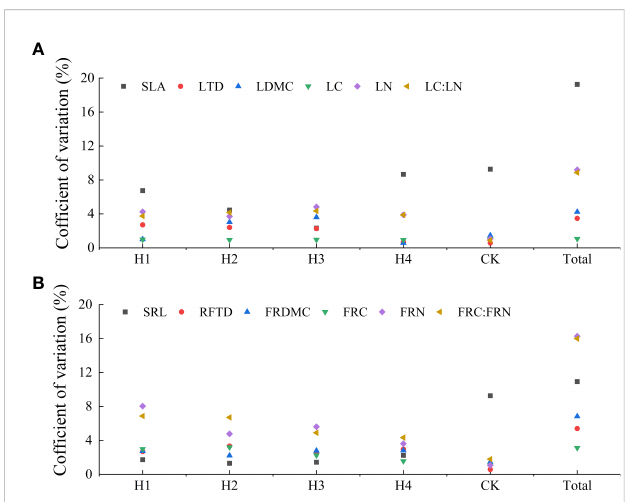
FIGURE 3 Variation traits of leaves (A) and fi ne roots (B) at different stump heights. Speci fi c leaf area (SLA), Leaf tissue density (LTD), Leaf dry matter content (LDMC), Leaf C content (LC), Leaf N content (LN), Leaf C:N ratio (LC : LN), Speci fi c fi ne root length (SRL), Fine root tissue density (FRTD), Fine root fry matter content (FRDMC), Fine root C content (FRC), Fine root N content, Fine root C:N ratio (FRC :